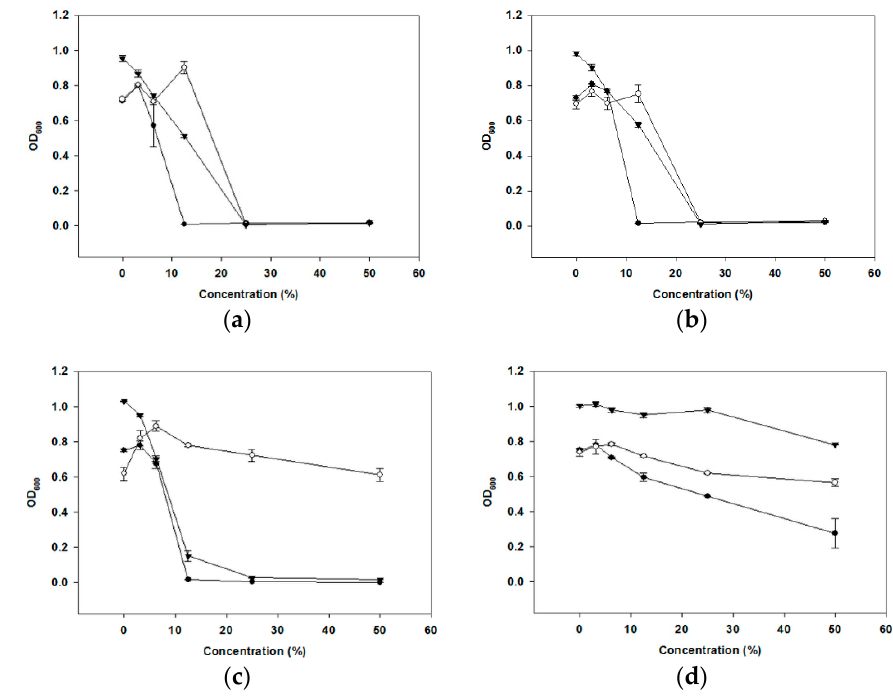
Figure 2. Dose-dependent effects of organic acid, hydrogen peroxide (H 2 O 2 ), and a bacteriocin-like compound (BLC) in the cell-free supernatants (CFS) of oraCMU against periodontopathogenic bacteria. Optical density at 600 nm (OD 600 ) of the cell suspension was measured. ( a ) Untreated CFS effect; ( b ) organic acid-dependent effect was measured using proteinase K and catalase-treated CFS; ( c ) H 2 O 2 -dependent effect was measured by the neutralized and proteinase K-treated CFS; ( d ) BLC-dependent effect was evaluated by the neutralized and catalase-treated CFS. P. gingivalis ( ● ); Fusobacterium nucleatum ( ○ ); P. intermedia ( ▼ ).